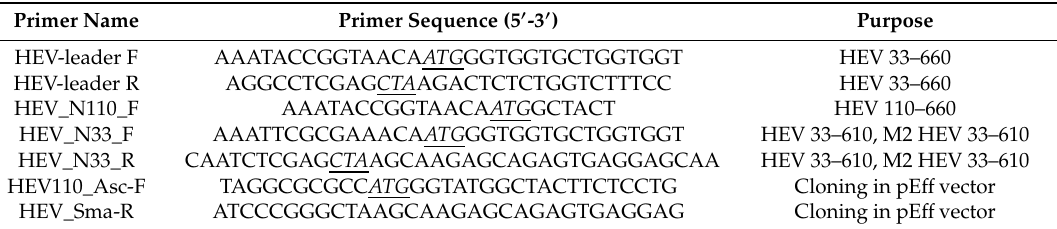
Table 1. List of primers used in this